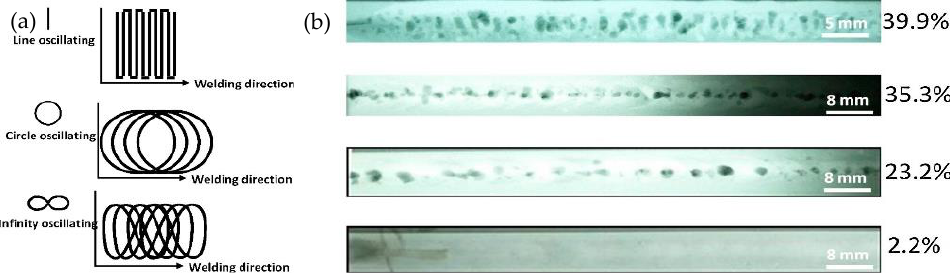
Figure 10. ( a ) Oscillating laser beam profile; ( b ) Porosity variation with different beam profiles. Reproduced with permission from Elsevier [125].